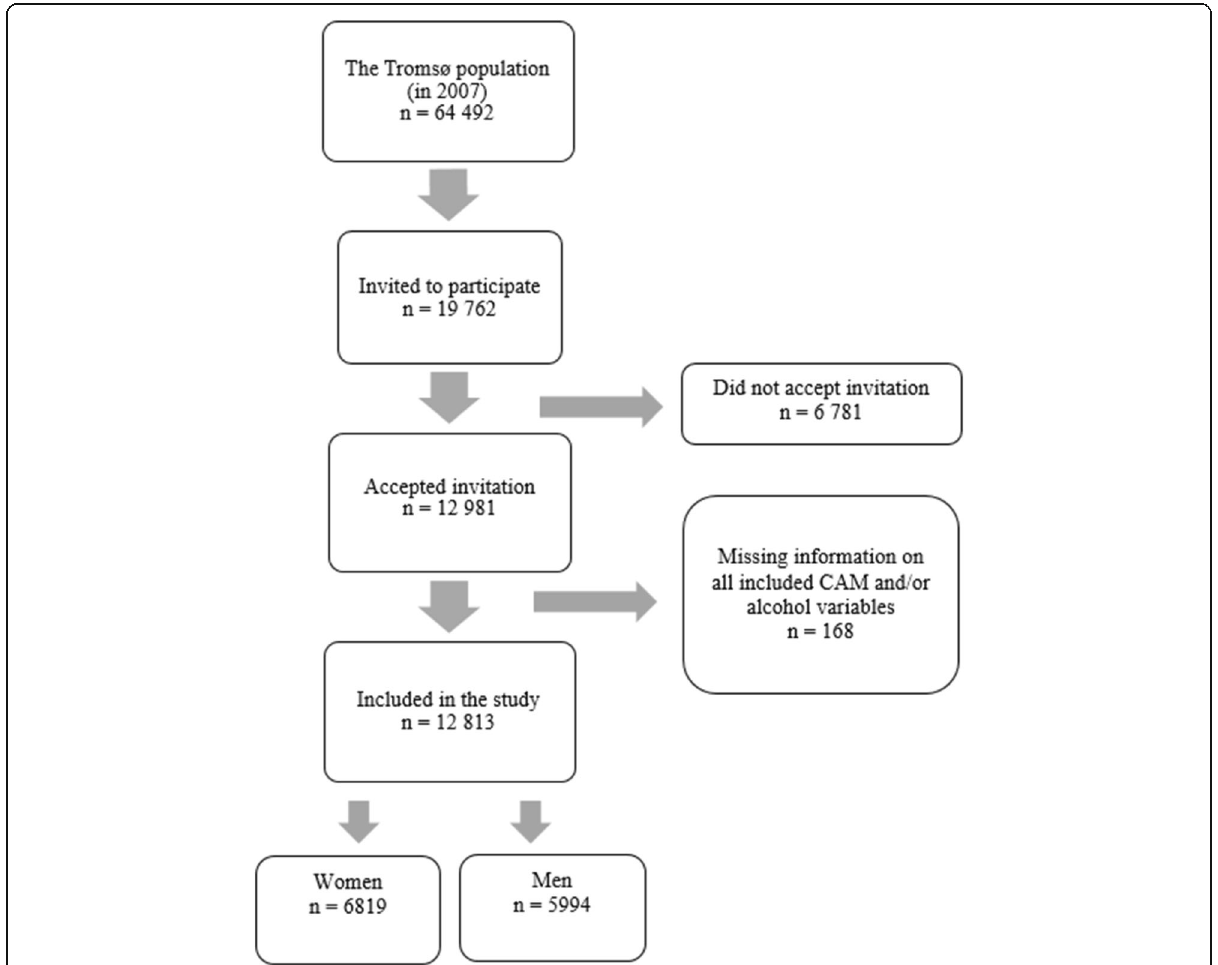
Fig 1 Flow chart of the studied